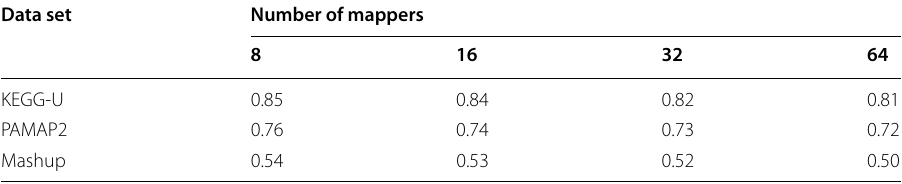
Classifier—AdaBooost, Cross-validation—tenfold, K NN